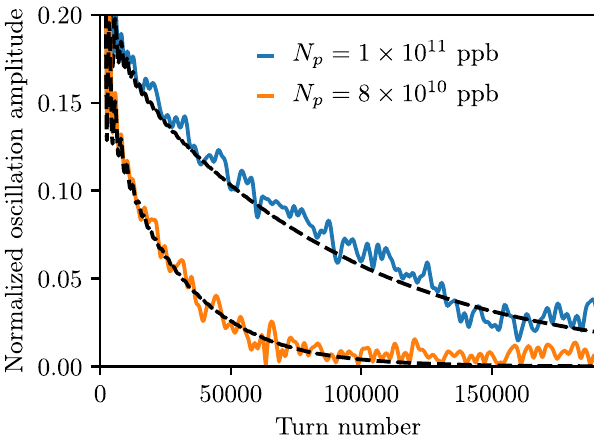
FIG. 14. Bunch offset evolution after a kick, found with MELODY using Eq. (62) (dashed lines) and from macroparticle simulations using BL on D (solid lines) for different bunch inten- ≈ 1 . 2 × 10 11 for a broad- sities below the LLD threshold N p; th 2 GHz; band impedance with Im Z=k ¼ 0 . 07 Ω , Q ¼ 1 and f r ¼ zero-intensity τ 4 σ ¼ 0 . 82 ns, μ ¼ 2 , and V 0 ¼ 6